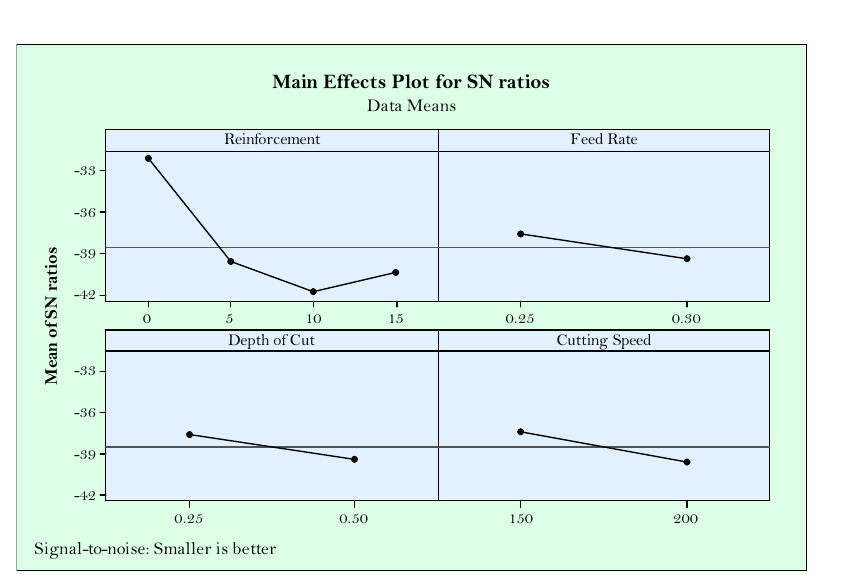
Figure 9. Main effect plots for S/N ratios of temperature.